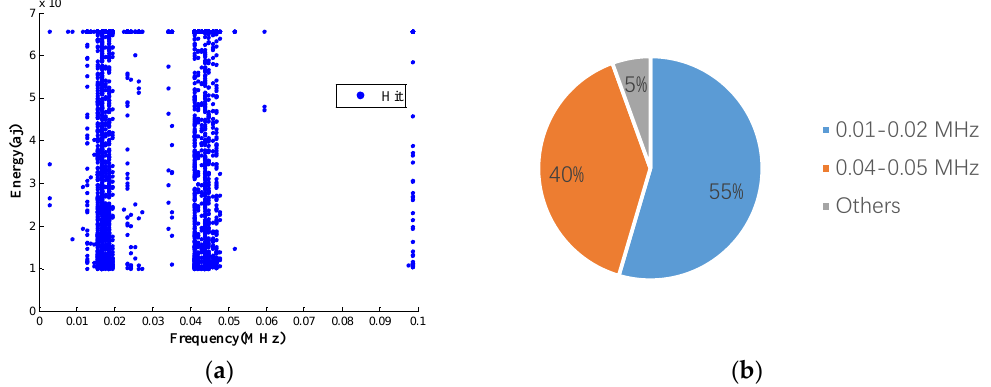
Figure 12. The frequency distribution of the second specimen: ( a ) frequency spectrum (energy > 10,000 aJ); ( b ) proportion of different frequency.